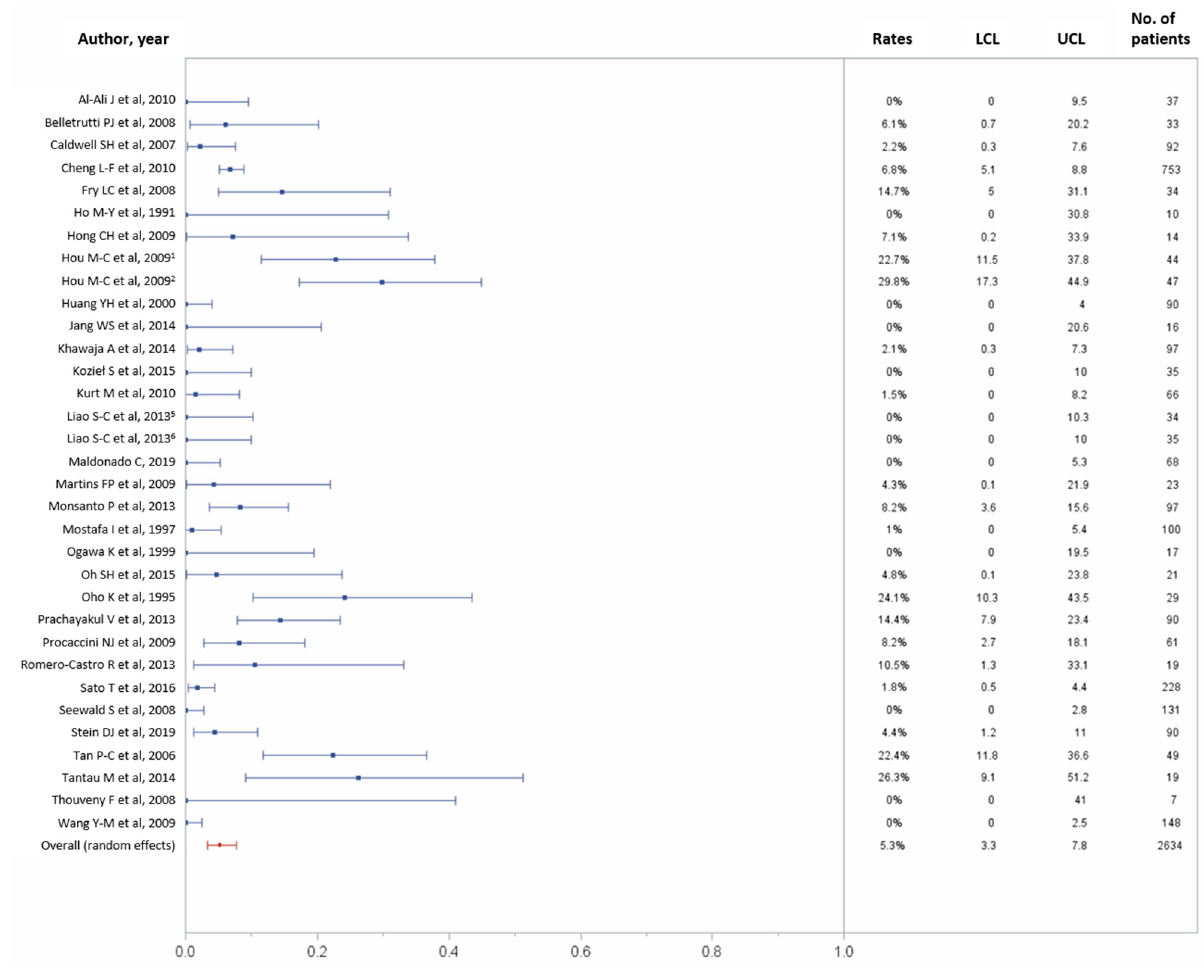
Figure 6. Forest plots of the 30-day major complications rates. Overall rate (random effects model): 5.3% (95% CI, 3.3–7.8%); heterogeneity: Q = 183.02, p < 0.0001, I 2 = 82.52%; UCL, upper control limit; LCL, lower control limit; No, number.